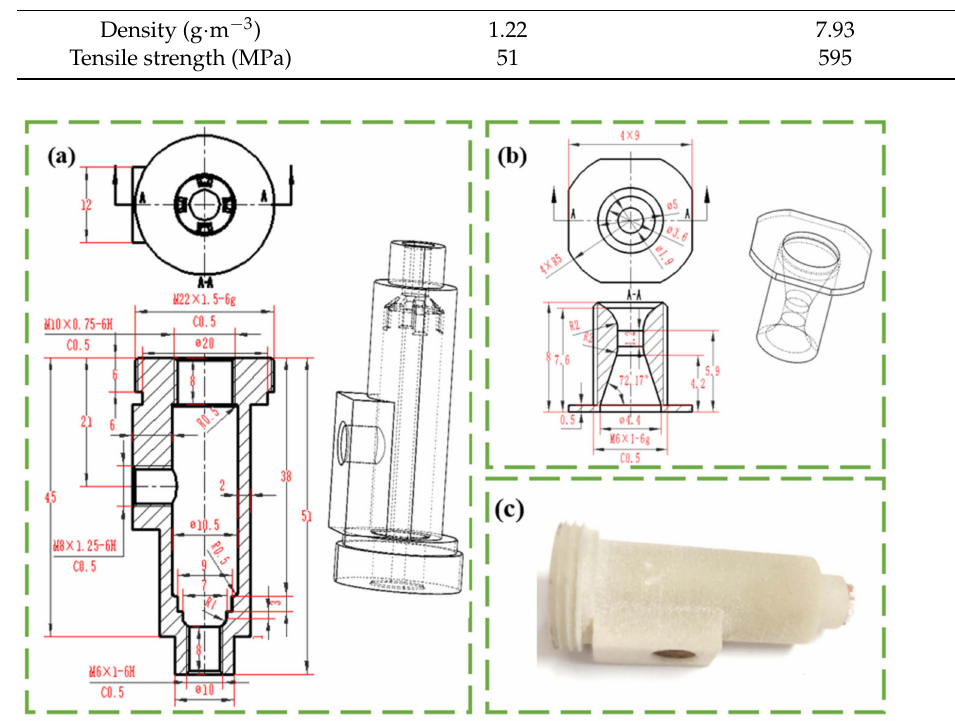
Figure 1. Schematic diagram of the motor: ( a ): shell produced by 3D printing, ( b ): nozzle manufac- tured by machining, ( c ): object